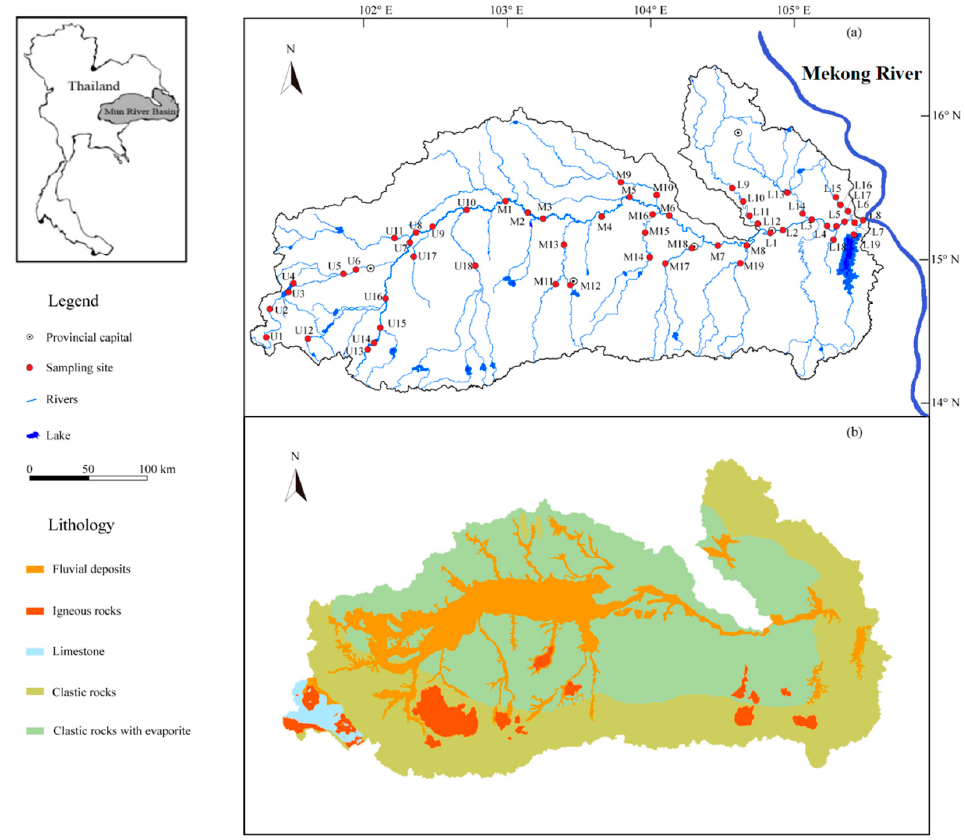
Figure 1. Maps of the Mun River Basin: ( a ) Sampling sites and geographical distribution ( b ) The geological map of the MRB.